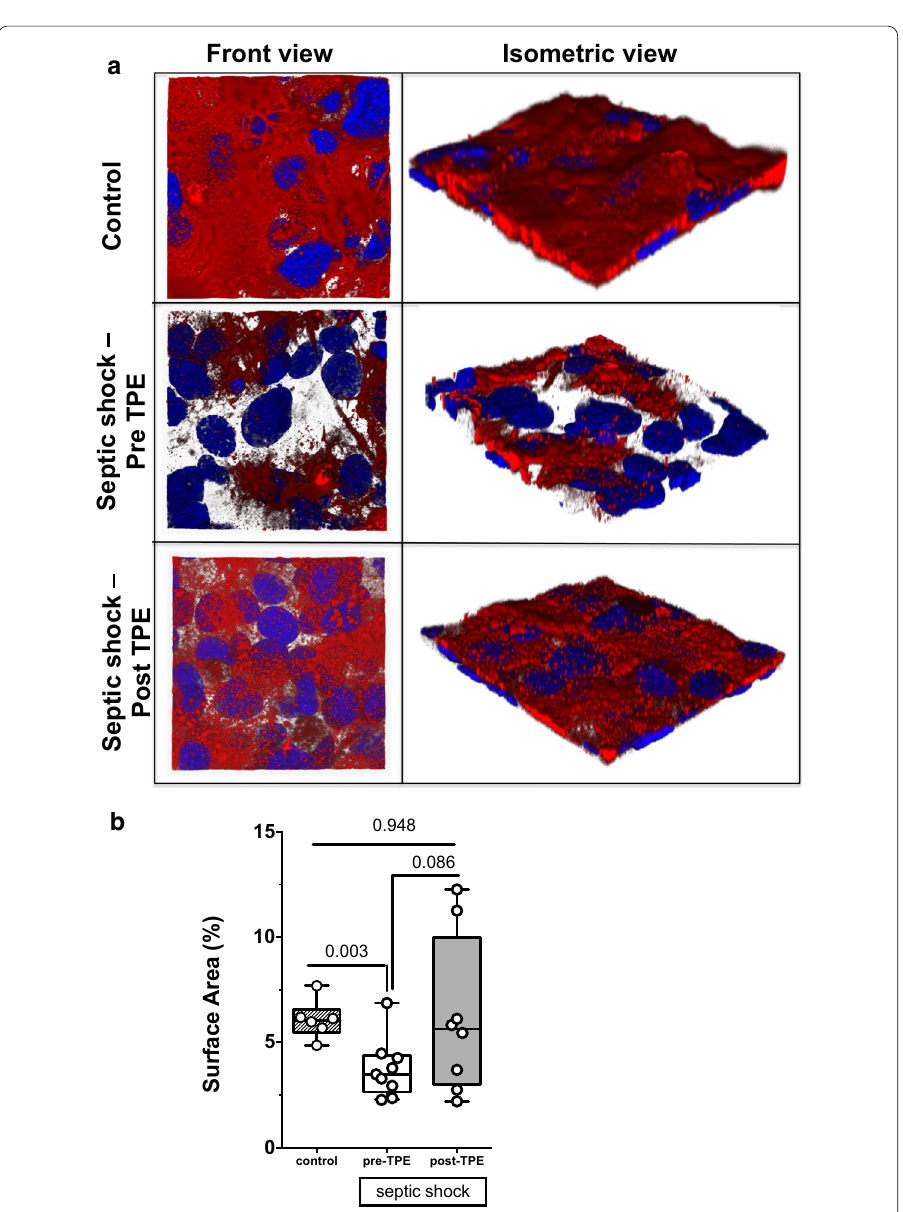
Fig. 5 Ex vivo stimulation of 3D microvessels with septic serum before and after therapeutic plasma exchange (TPE). Exemplary 3D reconstruction of the heparan sulfate (HS) layer images of naive endothelial cells in a microfluidic chip (HS in red, DAPI nuclei staining in blue) after perfusion with serum and incubation overnight of a representative septic patient both before and after TPE compared to healthy control serum (pooled out of four control patients) ( A ) and quantification of the HS positive surface area as box and whisker plots ( B